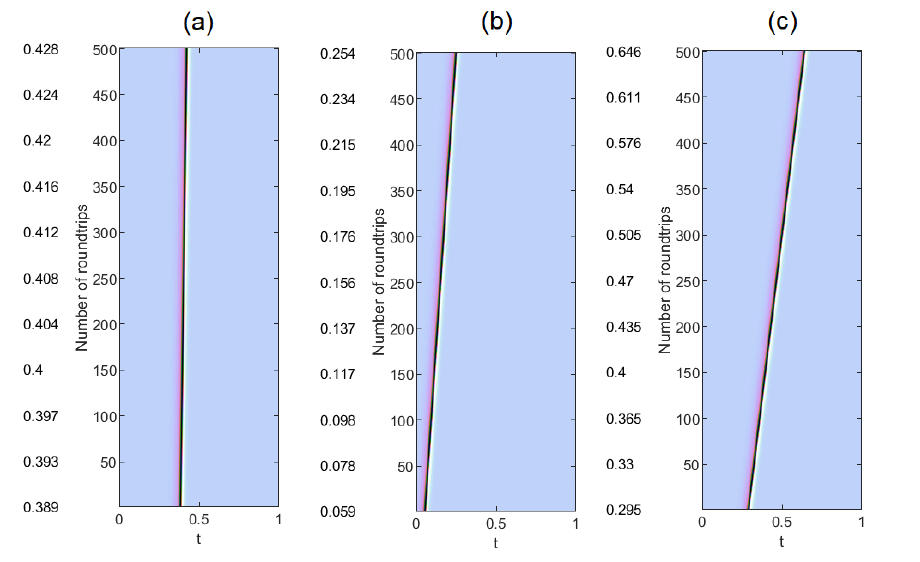
Figure 3. Spatio-temporal diagram of the field intensity over 500 roundtrips for b = 50 and ( a ) σ = 0.1, ( b ) σ = 0.5, ( c ) σ = 0.9. As σ increases the slope of the vertical line associated with the phase soliton decreases, indicating that the phase soliton moves more slowly. The shape of the pulse, instead, does not